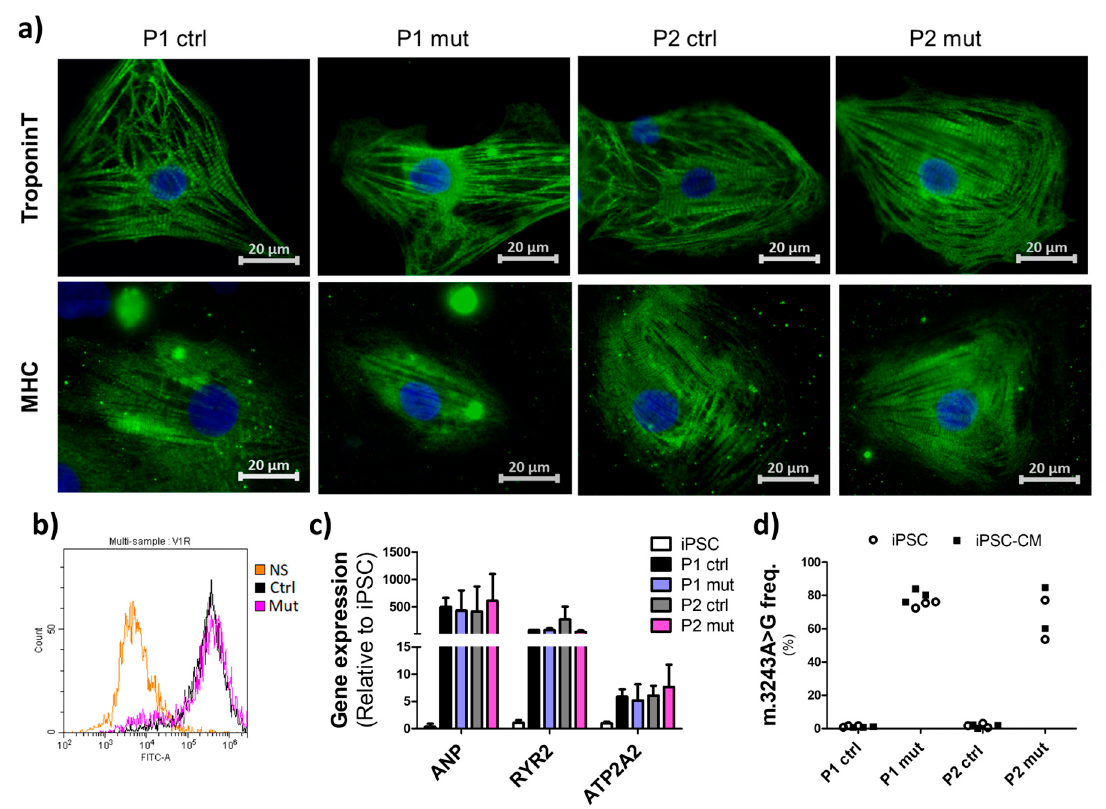
Figure 1. Characterization of iPSC-CMs. ( a ) Representative images of immunostaining for cardiac structural proteins cardiac troponin and Myosin Heavy Chain (MHC) (green) showing typical iPCS- CM morphology. Nuclear counter staining with DAPI (blue). Scalebars 20 µm. ( b ) Representative histograms from flow cytometry analysis for cardiac troponin T positive cells in iPSC-CM cultures with approximately 80% of the cells showing cardiac identity. NS = nonstained = no primary antibody. ( c ) Relative expression of cardiac specific genes in iPSC-CMs compared to iPSCs. Results are normalized against GAPDH (glyceraldehyde-3-phosphate dehydrogenase) expression and shown as mean +/-SD relative to one control line. Data from four independent experiments, n = 8. ( d ) Representative results from the quantitative PCR analysis of the m.3243A>G mutation load in the parental iPSCs and after cardiac differentiation (iPSC-CM) revealing stable mutation levels during differentiation.